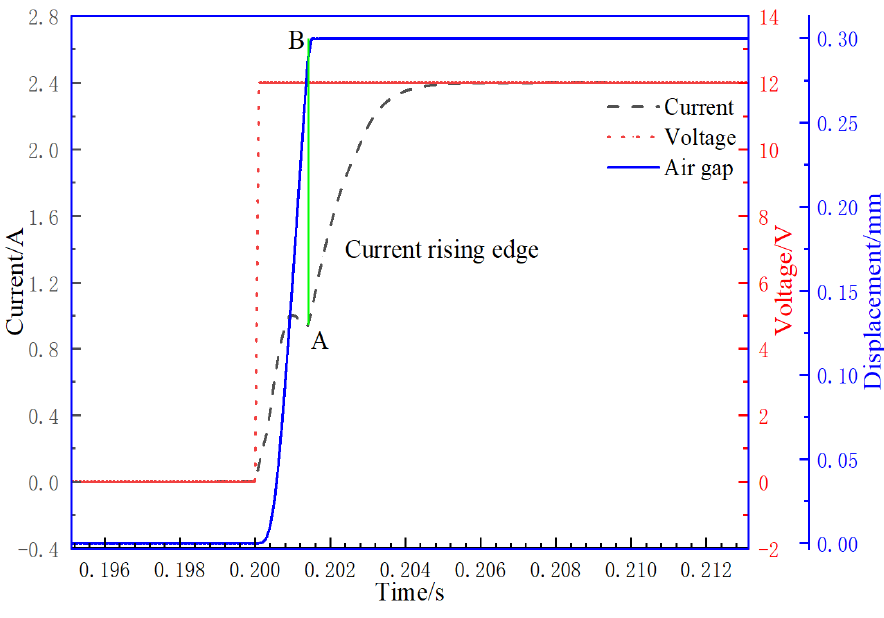
Figure 9. Response curve of current rising edge.